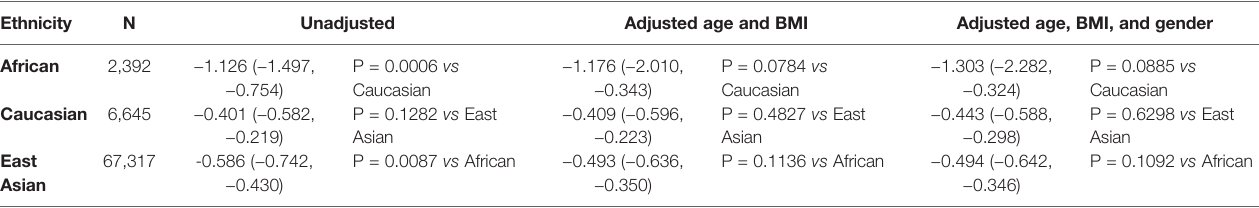
The relationship between lnHOMA-B and lnHOMA-S was analyzed using liner regression analysis in African, Caucasian and East Asian cohorts. The coef fi cient presented as mean (95% con fi dence interval) of the liner function before and after adjustment of age, BMI or gender was presented. HOMA-S, homeostasis model assessment-insulin sensitivity; HOMA-B, homeostasis model assessment- b -cell